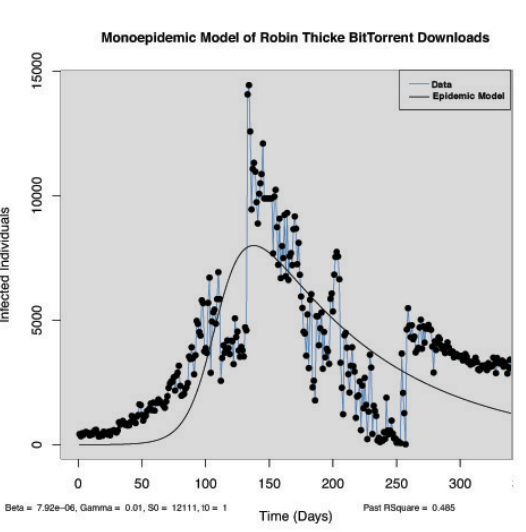
Figure 4: Monoepidemic SIR model fit to Robin Thicke Bit- Torrent download data